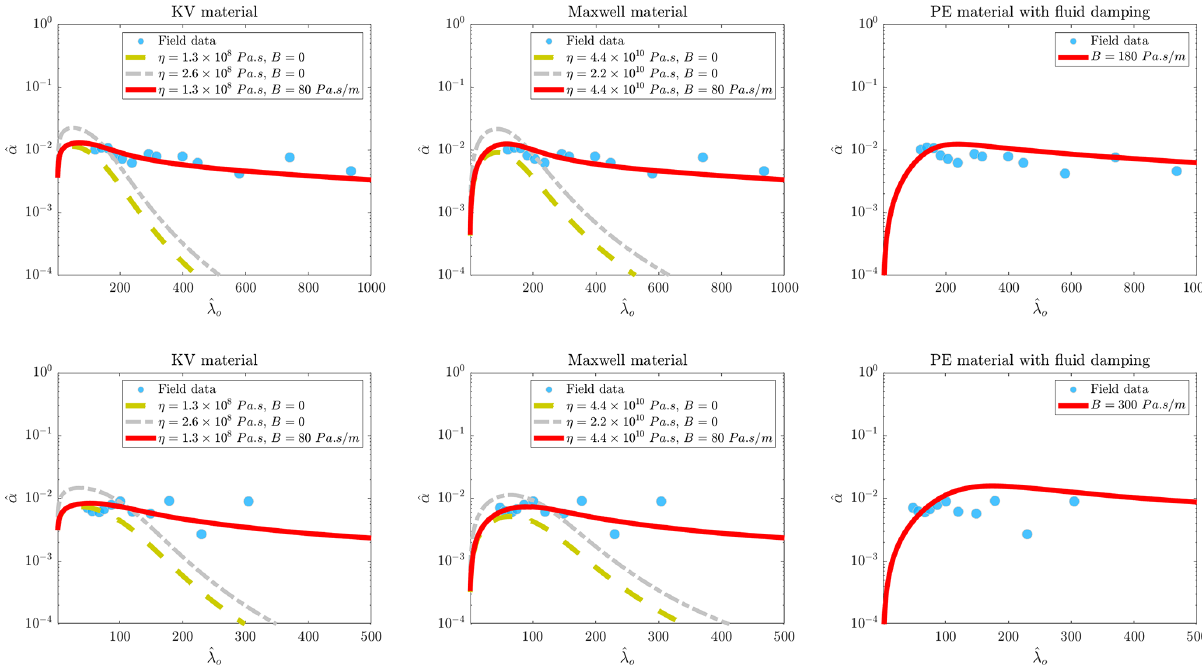
Figure 6. Comparisons between ˆ α vs. ˆ λ o curves predicted by different models and the data measured by Voermans et al. (2021). Upper and lower rows respectively show data measured in the Arctic and Antarctic. In the first and second columns, decay rates predicted by setting a zero fluid damping are also plotted. The shear modulus of ice is set to be